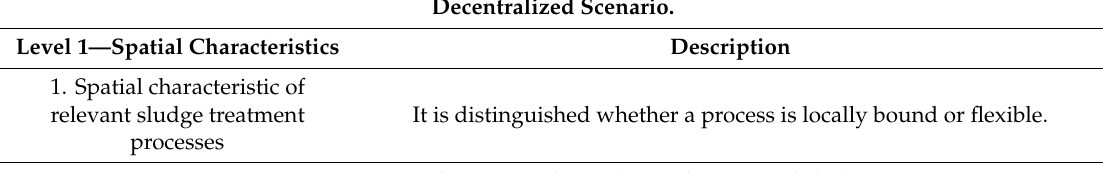
Table 4. Assumptions for the development of a decentralized scenario divided into levels 1 and 2. Decentralized Scenario.